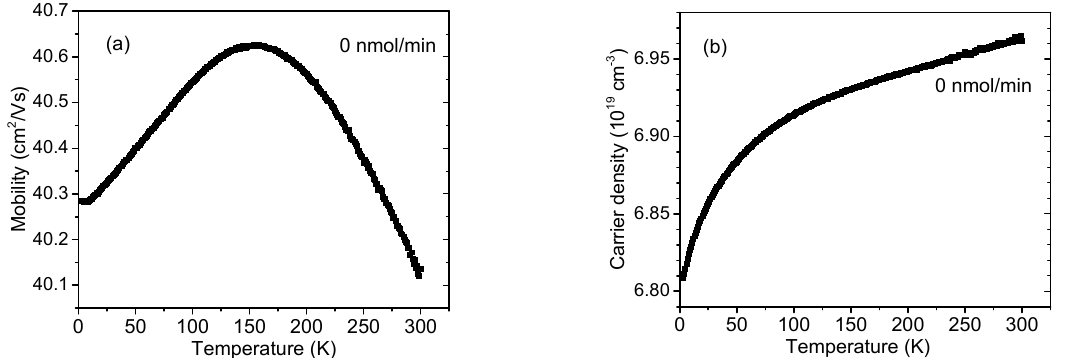
Figure 7. InAlN layer free electron ( a ) mobility and ( b ) concentration. Cp 2 Mg flow during the growth was 0 nmol/min.